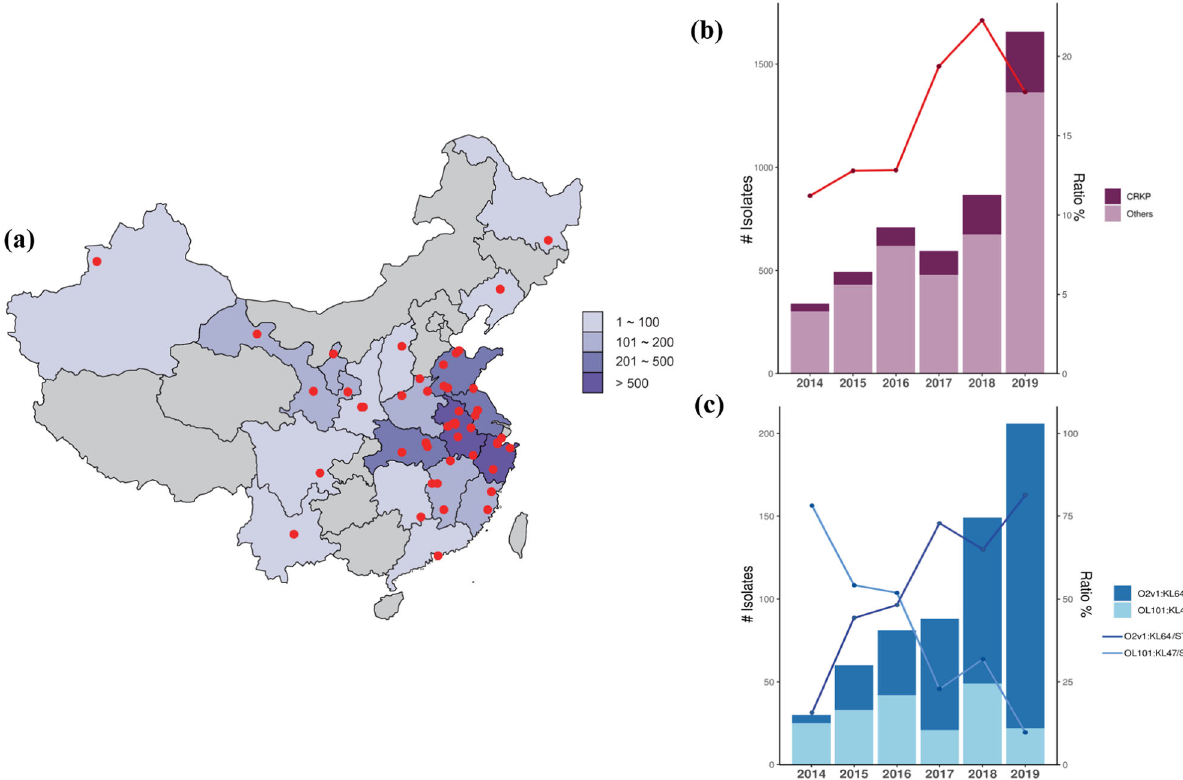
Fig. 1 | K. pneumoniae species complex bloodstream isolates collected in this studybetween2014and2019.a Geographicaldistributionof45sentinelhospitals participating in this study. The number of isolates collected in each province is shown by color gradients at the right. b The graph shows the number (dark red